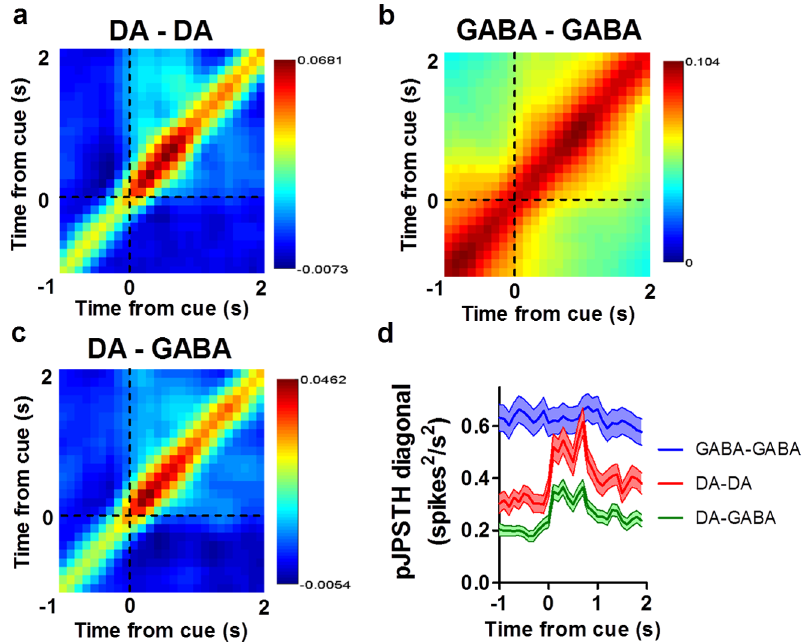
Figure 5. Population JPSTH analysis. ( a ) Normalized population JPSTH (pJPSTH) of all DA-DA pairs ( n =185 pairs). Synchrony was enhanced immediately after the onset of the cue. ( b ) Synchrony among GABA-GABA pairs ( n =475 pairs) was not affected by the reward cue. ( c ) Synchrony between DA and GABA neurons ( n =394 pairs) was enhanced following the reward cue. pJPSTH bins are 100 ms 6 100 ms. Values are normalized by the standard deviation of predictor matrices. ( d ) The diagonal of each corrected pJPSTH is plotted (width =500 ms, bins =100 ms). DA-DA and DA- GABA pairs showed enhanced synchrony following the cue, whereas cue-elicited synchrony was not observed among GABA-GABA pairs. Only those neurons showing significant excitation following the reward cue were included in the